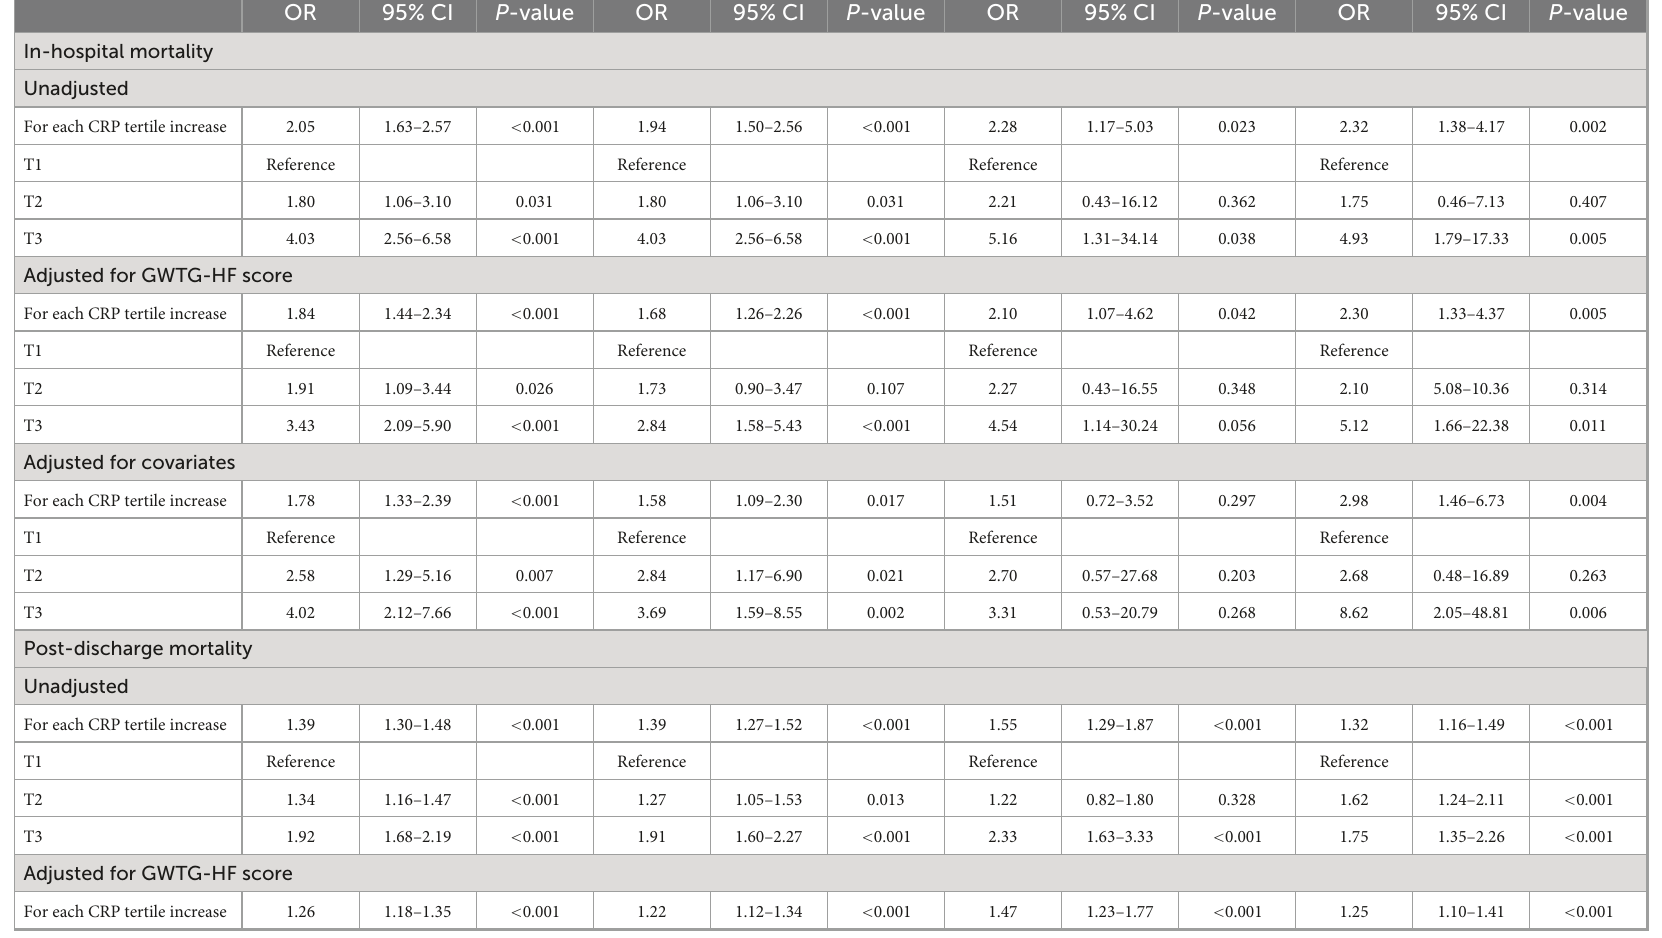
TABLE 2 Prognostic value of C-reactive protein (CRP) tertiles according to the heart failure (HF) categories. All HFrEF HFmrEF HFpEF OR 95% CI OR 95%